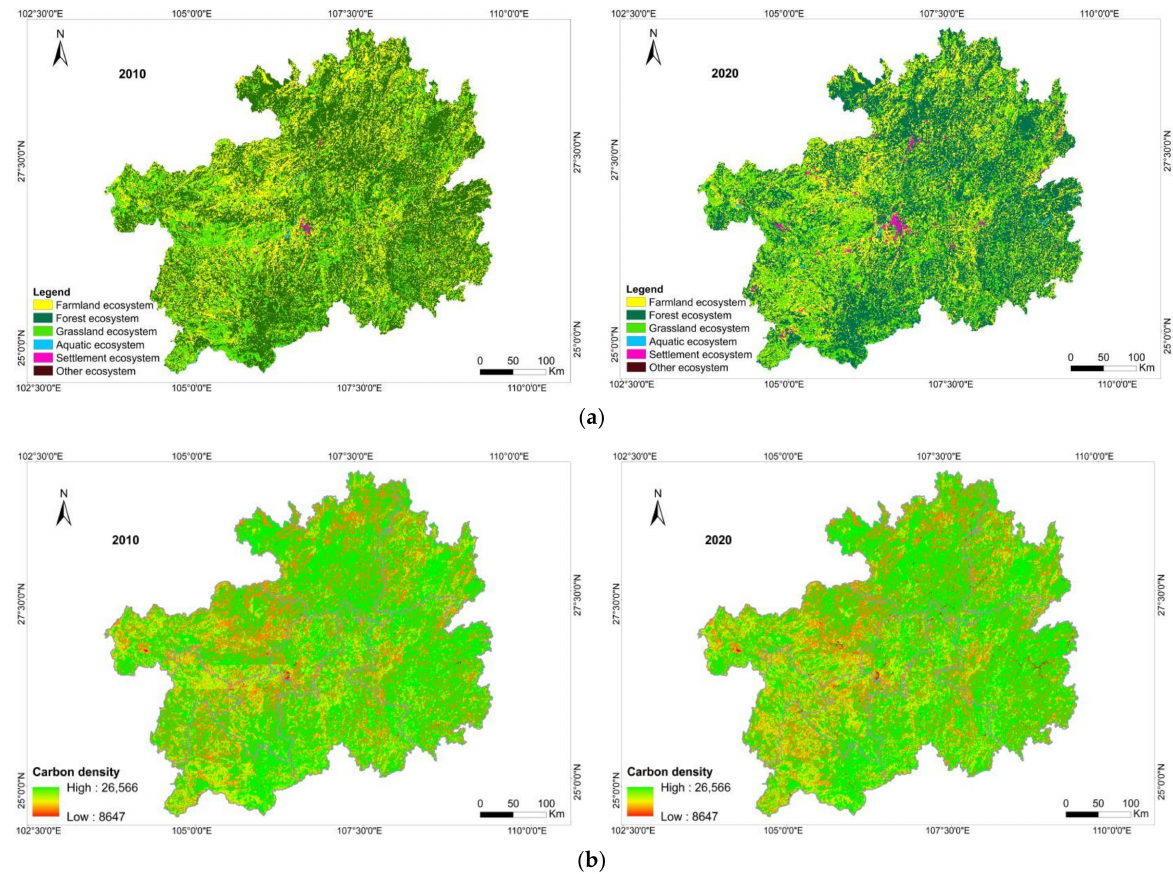
Figure 4. ( a ) Spatial distribution of the terrestrial ecosystem in 2010 and 2020; ( b ) spatial distribution of carbon storage in 2010 and